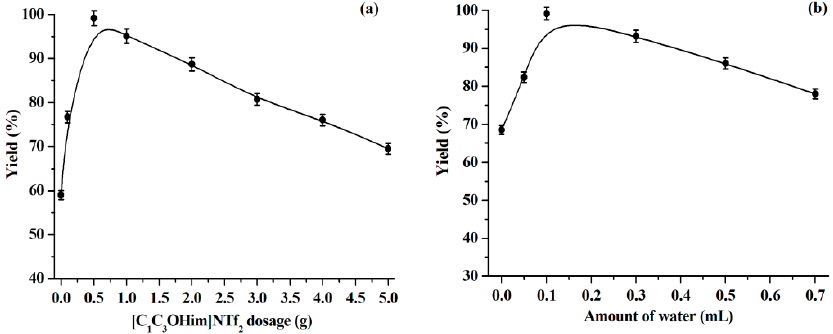
Figure 3. Influence of the dosages of [C 1 C 3 OHim]NTf 2 ( a ) and water ( b ). Reaction conditions: ( a ) BA, 1.0 mmol, water, 0.1 mL, reaction time, 168 h, temperature, 50 °C, lipase, 30 mg, 4-HC, 0.5 mmol. ( b ) BA, 1.0 mmol, reaction time, 168 ho, temperature, 50 ◦ C, lipase, 30 mg; 4-HC, 0.5 mmol, [C 1 C 3 OHim]NTf 2